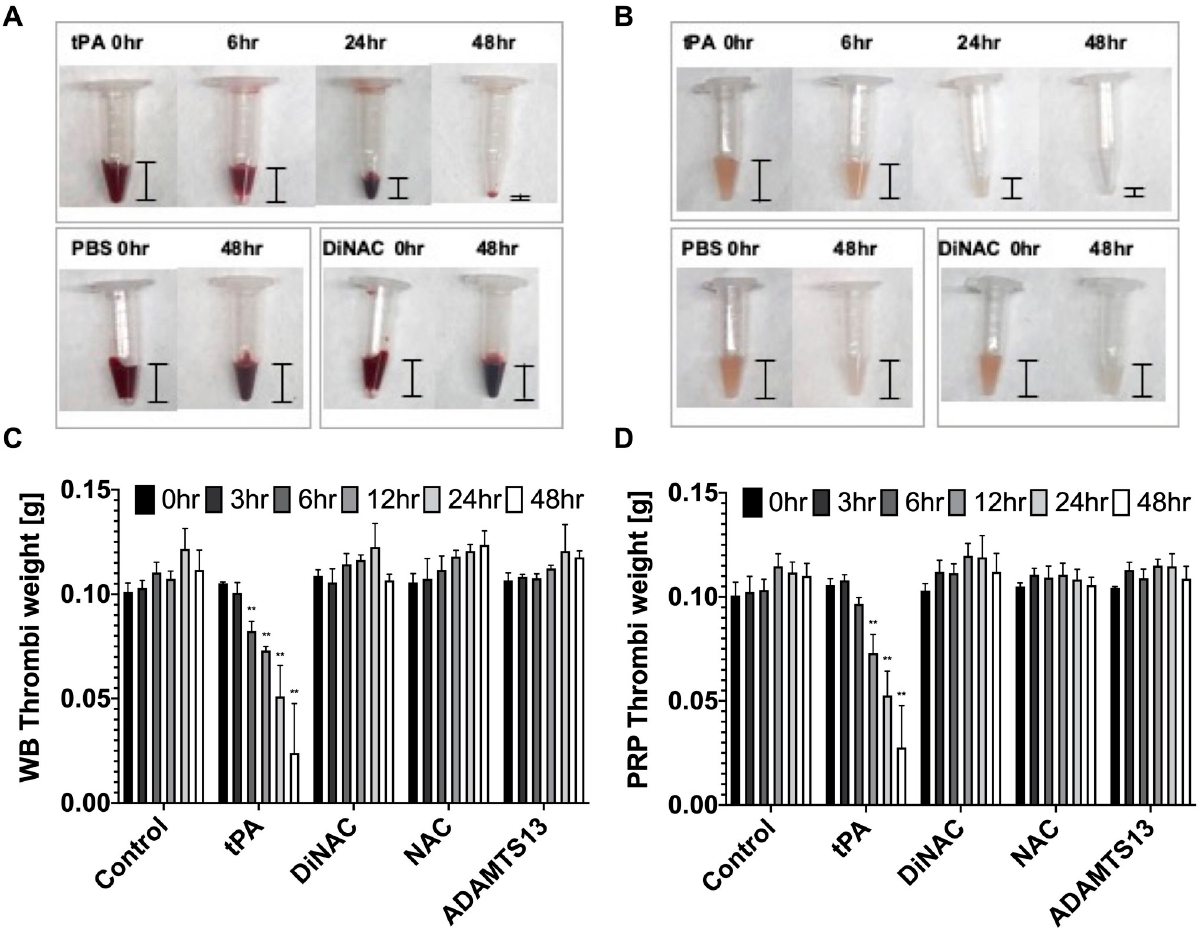
Fig 5. Lysis results on fibrin clots formed under stagnant conditions (n = 3 per agent). DiNAC and NAC were tested at a concentration of 2 mM. A Whole blood clot lysis over 48 h. tPA showed a large decrease in clot volume. B PRP clot lysis over 48 h. tPA again showed a large decrease in clot volume. C and D Whole blood and PRP clot weight change over 48 h. tPA lysed clots resulting in a weight change significantly different from baseline after 6 h for whole blood and 12 h for PRP (26% and 36% reduction, respectively, �� p < 0.01). DiNAC, NAC, and ADAMTS-13 had no effect on red clots, with no differences from baseline nor